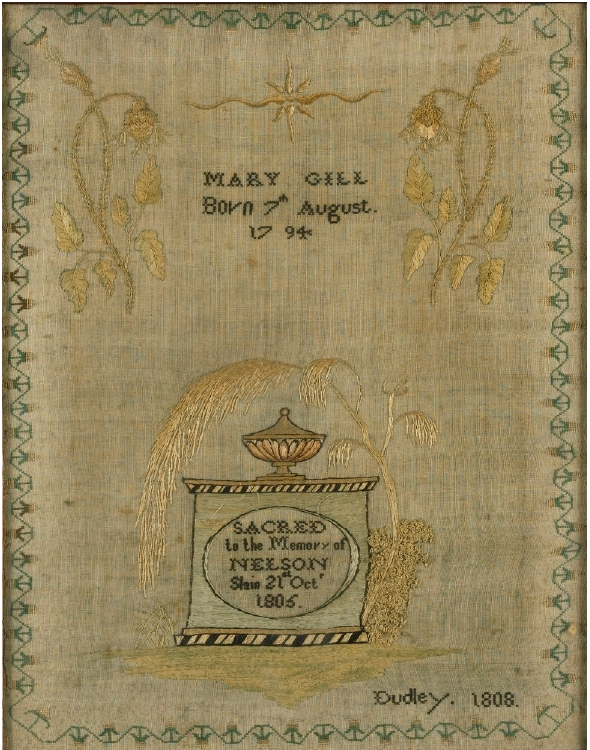
Figure 3: Mary Gill’s sampler (Object ID TXT0031) © National Maritime Museum, Greenwich,